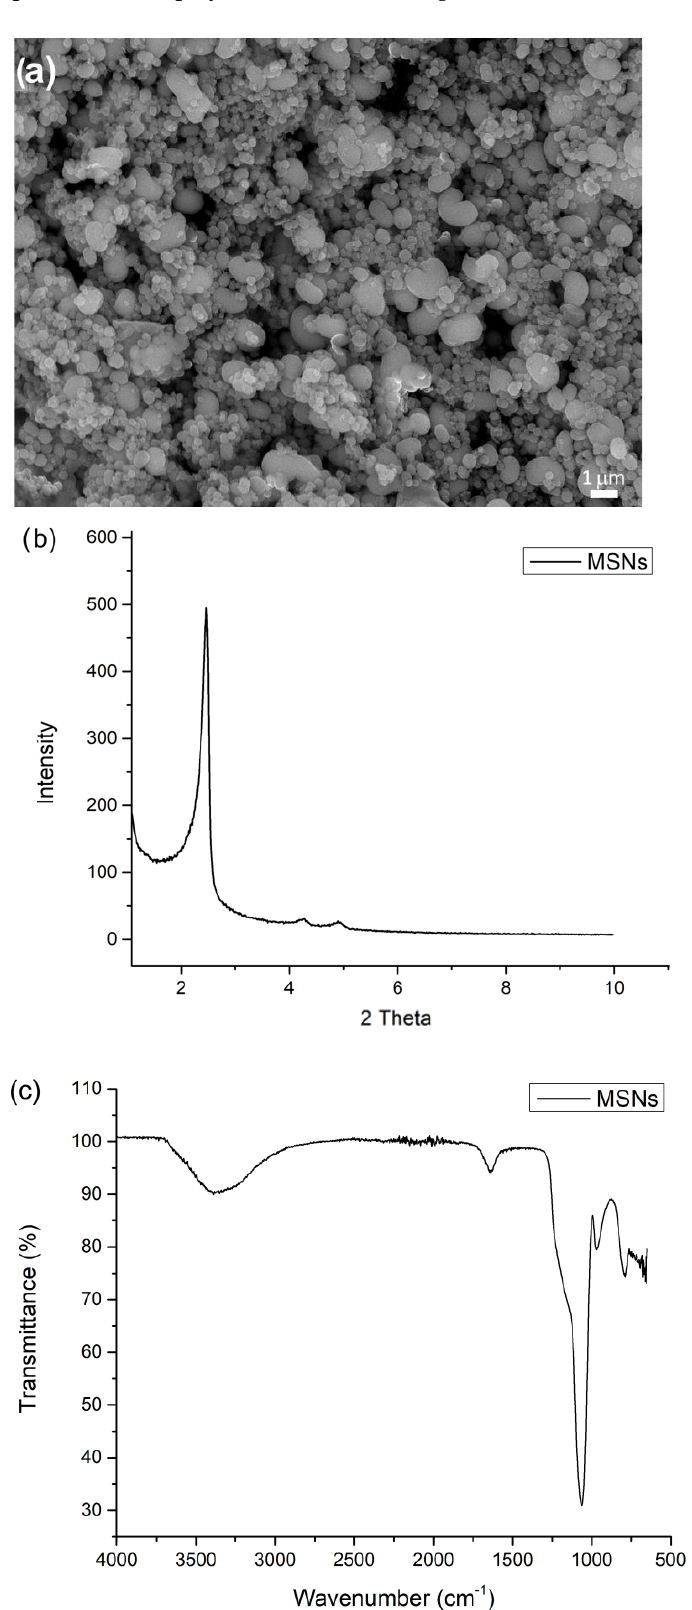
Figure 1. Characterization of the MSNs: ( a ) SEM image, ( b ) SAXRD diffractogram, and ( c ) FTIR spectrum.